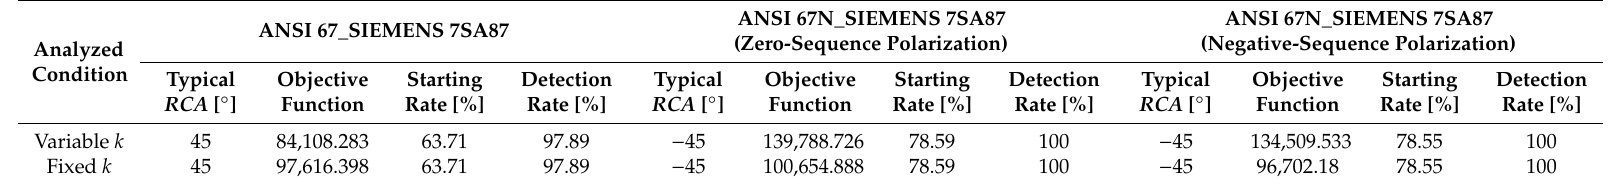
Table 3. Obtained results for the 7SA87 relay at LT_1 SE_A and typical